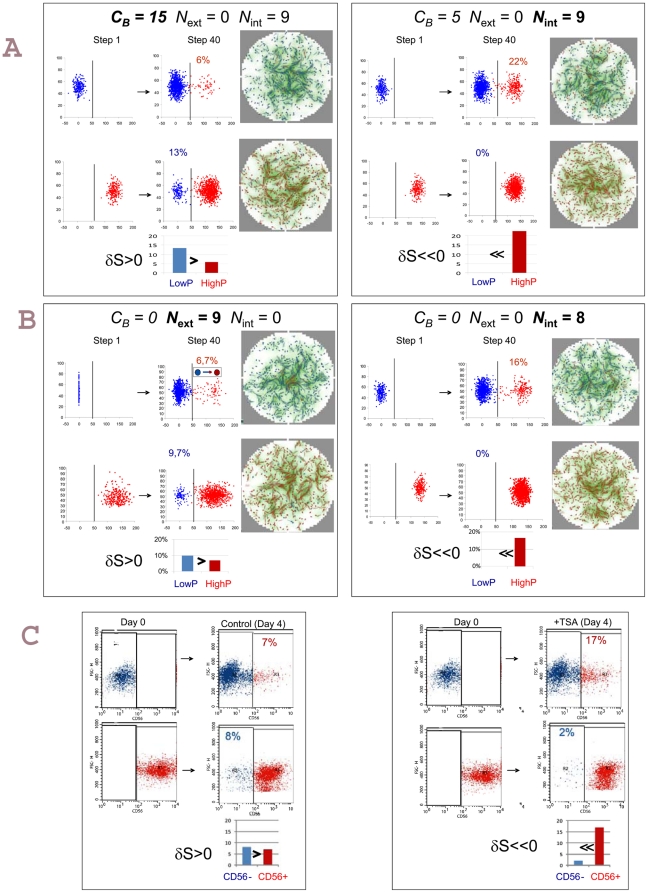
Examples of simulations and effect of TSA.A. Examples taken from the parameter space presented on the Fig. 5. The left panel is an example of strong dependence (CB = 15) of the kinetic parameter B on local cell density where “low P” (blue) cells switch to “high P” slower than the opposite: δS>0. The right panel is an example of weak (CB = 5) dependence of the kinetic parameter B on local cell density where “low P” (blue) cells change phenotype easier than the “high P” cells: δS <0. The small diagram indicates the fraction of the cells that changed phenotype. Note the density-dependent distribution of the blue and red cells as shown by the virtual “immunochemical” analysis of the cell phenotypes. The graded background is indicative of the local concentration of R decreasing from white to green. B. Examples taken from the parameter space on Fig. 5 with the high context-dependent/low intrinsic (left panel) and high intrinsic (right panel) noise regimes. Note the difference in the conversion rates of the sorted “high P” and “low P” cells depending on the noise regime as shown by the virtual cytrometrical analysis. The spatial distribution of the “high P” (red) and “low P” (green) cells is different depending on the noise regime as shown by the virtual immunochemical analysis of the cell phenotypes. C. Trichostatin (TSA) treatment of the living cells reproduces the effect of the high intrinsic noise: the cytometry analysis of sorted and TSA treated CD56− (blue) and CD56+(red) cells compared to non-treated controls shows high conversion rate of the sorted “high P”(red) cells compared to “low P”(blue) cells (right panel). The control untreated cells show the previously observed conversion rates typical either for strong dependence of parameter B on local cell density or for high context-dependent/low intrinsic noise regime.